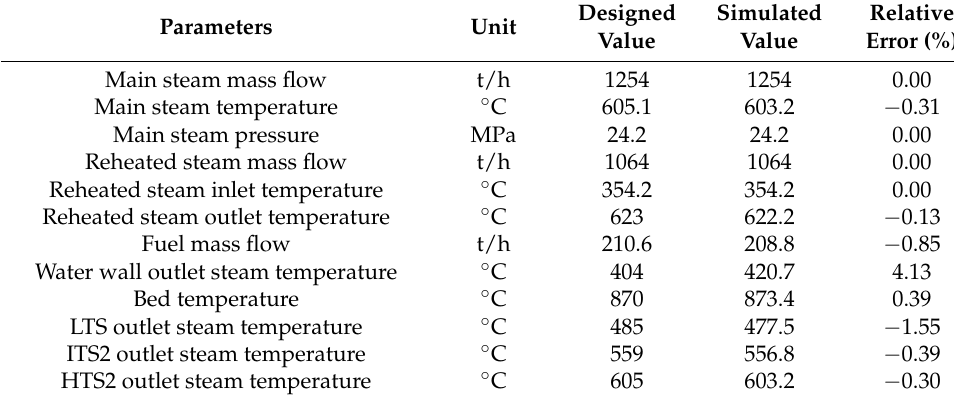
Table 2. Simulation results at 75%